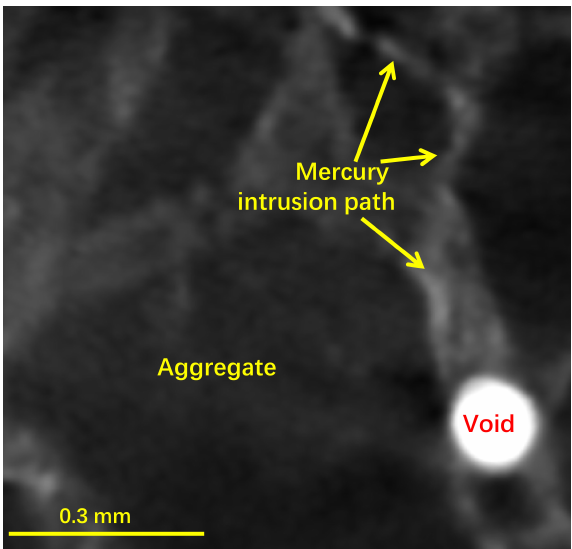
Figure 10. A 2D sectional image of a local area in the mortar showing a mercury intrusion path along the ITZs between aggregates and cement matrix to an air